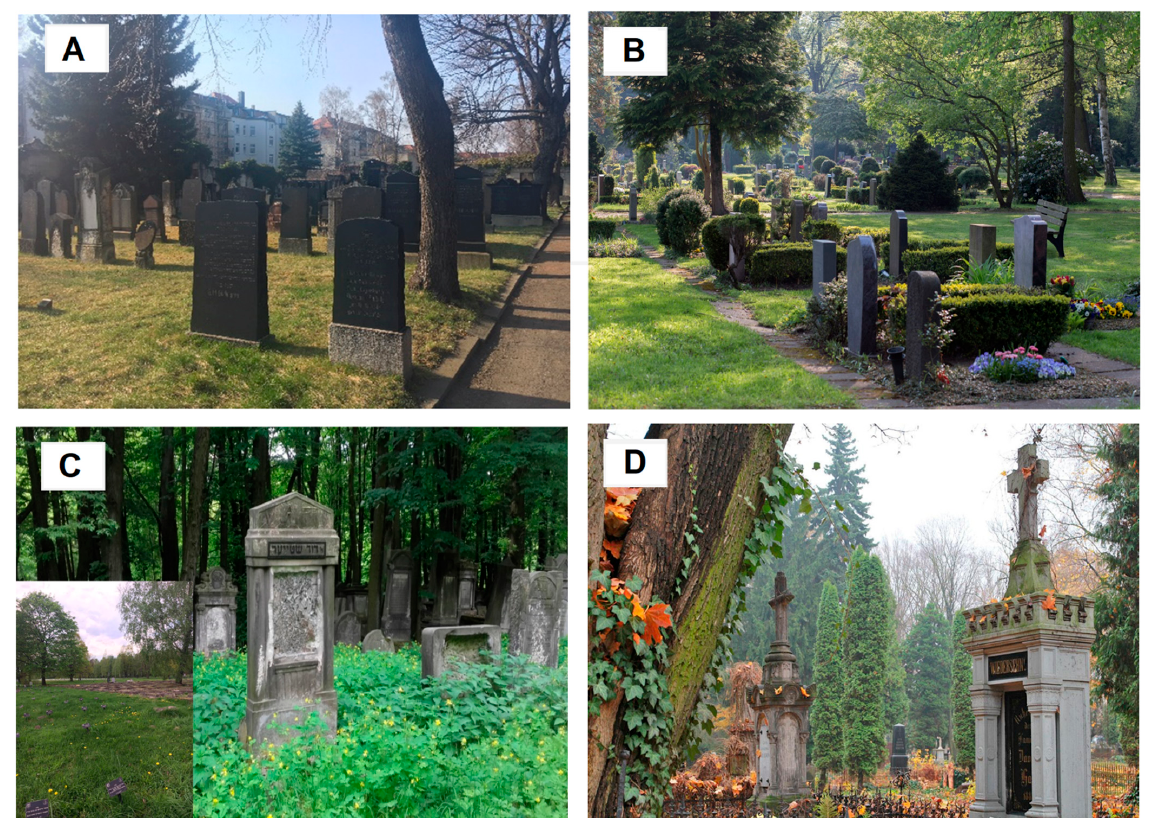
Figure 6. Views on case studies (site observation): ( A )—Old Jewish Cemetery in Leipzig (Germany), ( B )—Südfriedhof Cemetery in Leipzig (Germany), ( C )—Jewish Cemetery in Ł ód ź (small photo: